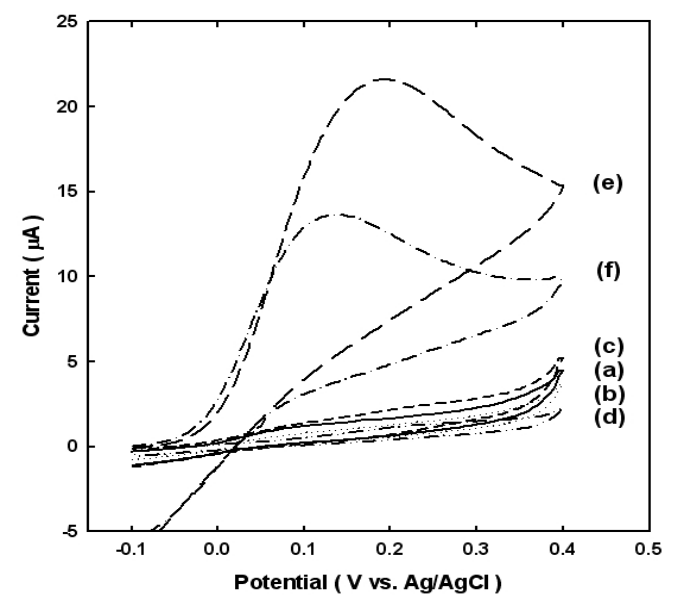
Figure 2. CV data of nonspecific binding conformation for various processes: O electrode bound 4-MBA and the streptavidin, (b) Au@Nb (a) Au@Nb 2 5 bound 4-MBA, the streptavidin and BSA, (c) Au@Nb streptavidin , BSA and biotinylated anti-mouse IgG, (d) Au@Nb 4-MBA, the streptavidin, BSA, biotinylated anti-mouse IgG and goat IgG, (e) Au@Nb electrode bound 4-MBA, the streptavidin , BSA, biotinylated anti-mouse IgG and mouse IgG, (f) the quantity of ALP-conjugated anti-mouse IgG antibody reduce 1/10 times than (e) electrode. All CV were obtained after incubating for 1min in EB containing 1 mM APP and at a scan rate of 20 mV s − 1